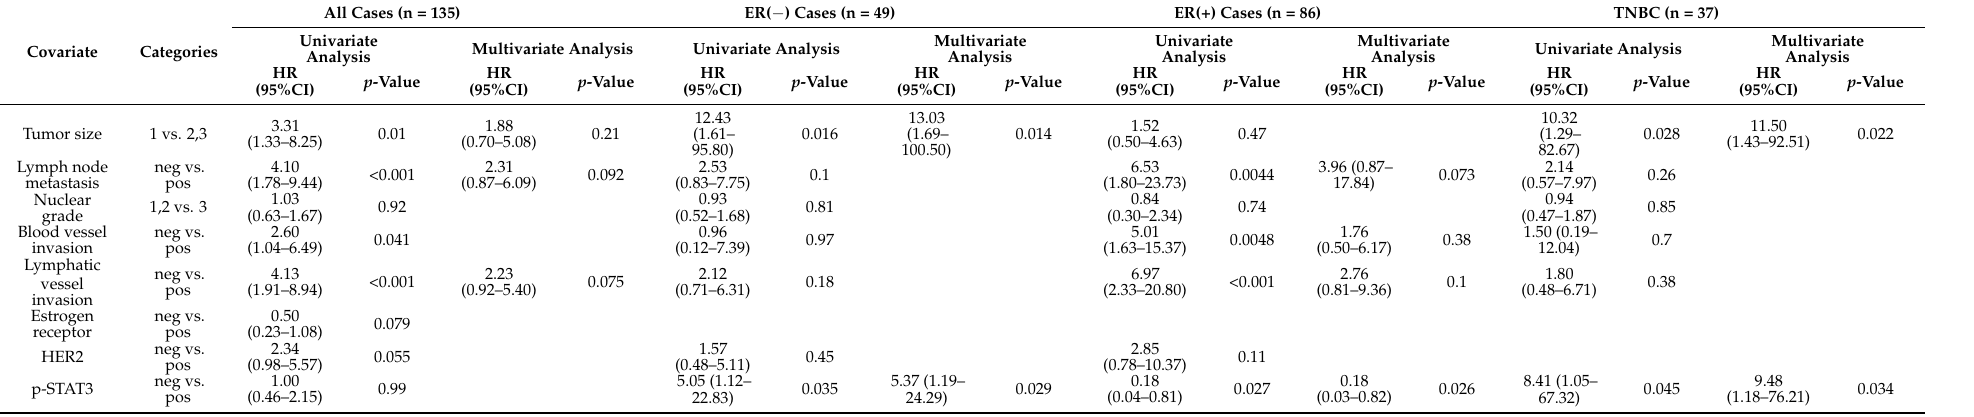
Table 4. Cox proportional hazards regression model analysis of RFS in all cases, ER( − ) cases, ER(+) cases and TNBC